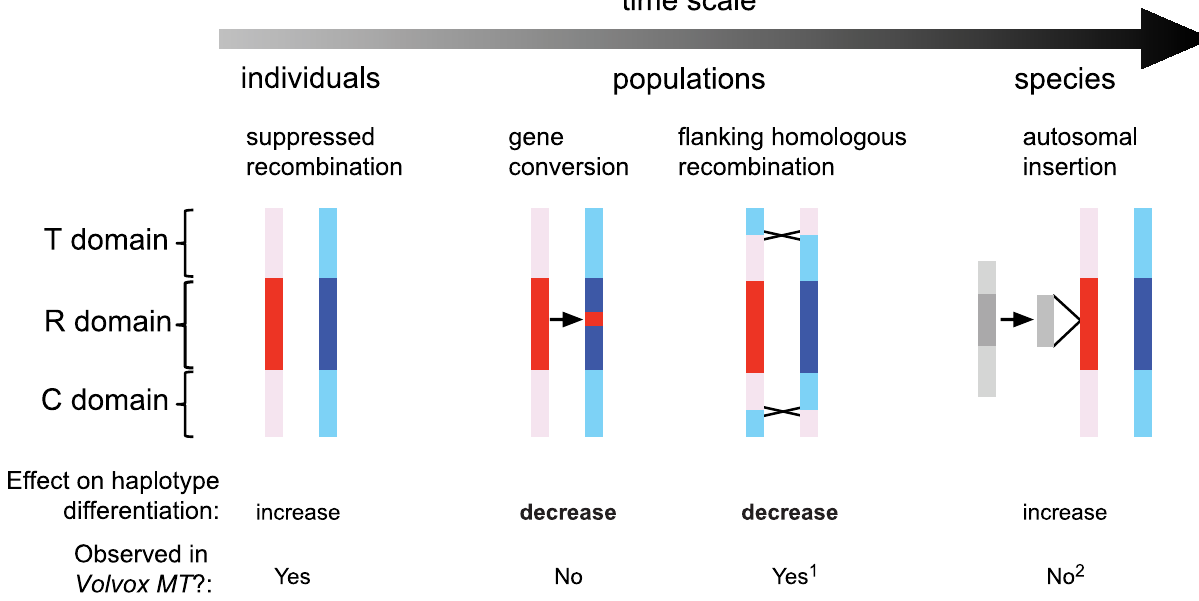
Figure 7. Genetic processes that shaped evolution of the Chlamydomonasreinhardtii mating locus. The time scale arrow on top represents a frequency continuum for genetic processes affecting MT that are detectable within individual generations, within populations, or in the species. Models of genetic exchange show the MT haplotypes in red ( MT + ) and blue ( MT 2 ) with the rearranged (R) domain shaded dark and the flanking telomere-proximal (T) and centromere-proximal (C) domains shaded light. From left to right: In individuals little or no genetic exchange is observed in crosses due to suppressed recombination; In populations occasional gene conversion within the R-domain, and crossover exchange or gene conversion in the T and C domains act to homogenize genetic variation that accumulates between haplotypes; At the species-level autosomal insertions (gray shaded regions) have occurred at least three separate times in the MT + haplotype and spread to fixation, thereby adding new mating-type-limited genes to the locus. The lower section summarizes the impact of genetic interactions in Chlamydomonas MT in terms of increasing or decreasing haplotype differentiation and whether such interactions occur in Volvox MT . Notes: 1, Suppressed recombination in Volvox MT does not appear to extend beyond the R-domain as it does in Chlamydomonas [11]. 2, Only unique autosomal sequence insertions (but not transposons or repeats) are considered in this schematic.